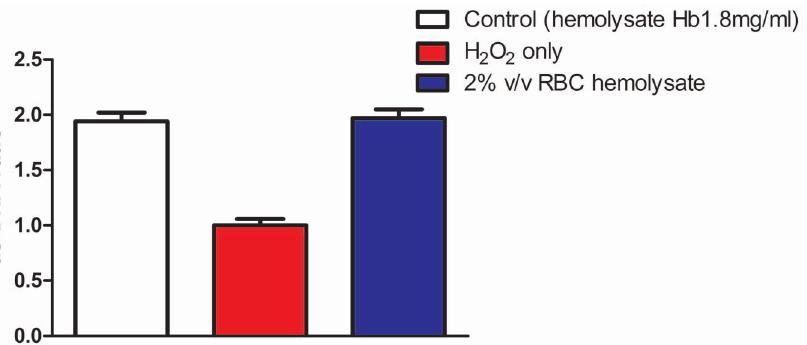
Figure 4. ds-DNA ratio in H 2 O 2 -stimulated PBMC: effect of purchased human hemoglobin (1.8 mg/ml) and RBC hemolysate (2% v / v , mean hemoglobin content=2.00 6 0.07 mg/ml). b vs a, p , 0.001; c vs a, p , 0.001; N=8.